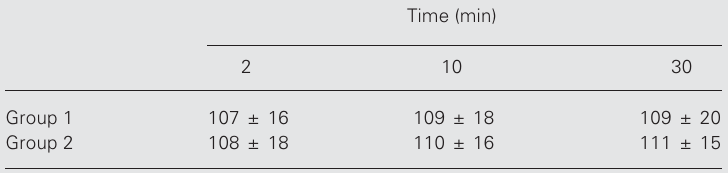
Table 3. Inotropic response to L-NAME by isolated